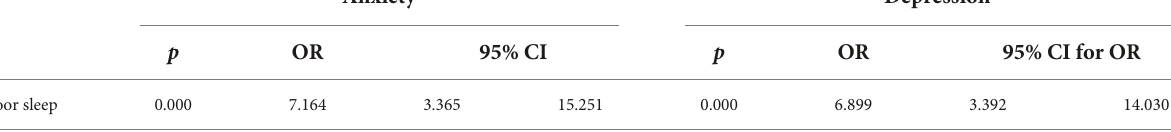
TABLE 2 Binary logistics regression analysis of anxiety and depression among medical workforce.